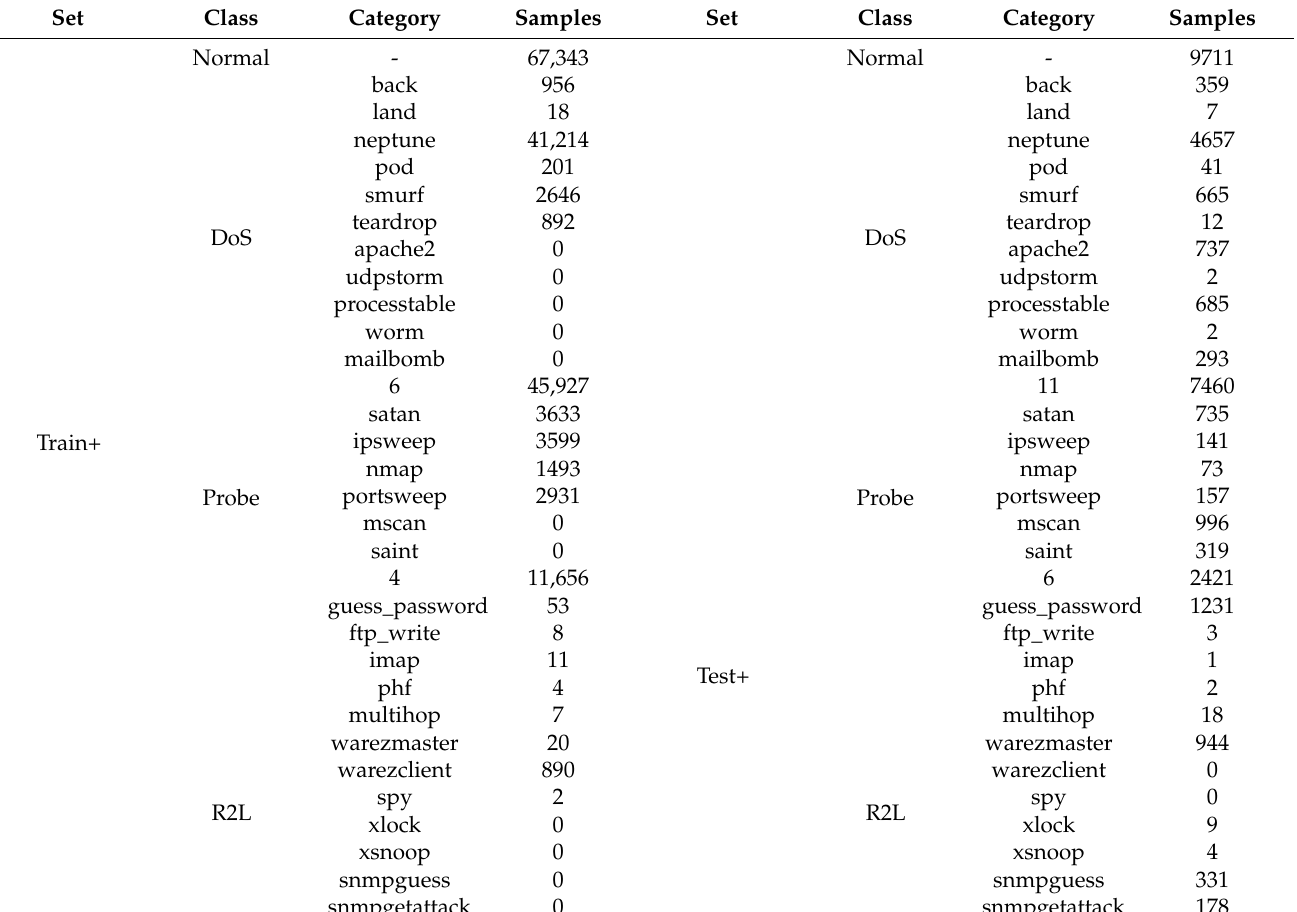
Table 2. Class detail composition of